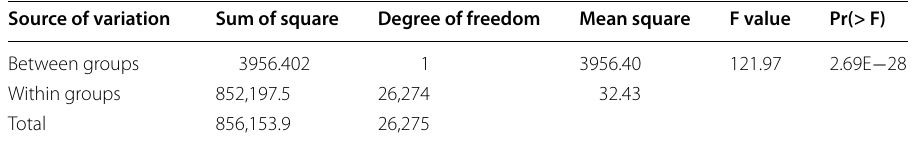
Table 9 Results of ANOVA test for effect of author keyword and KeyWords plus Source of variation Sum of square Degree of freedom Pr(> F) Between groups 3956.402 Within groups (F-crit 3.84) =